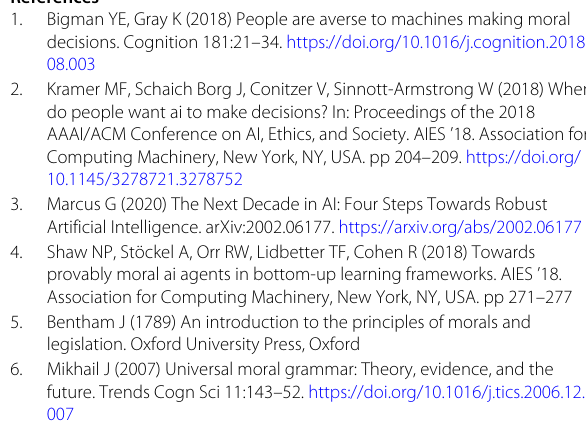
be applied to other, more complex moral scenarios and network